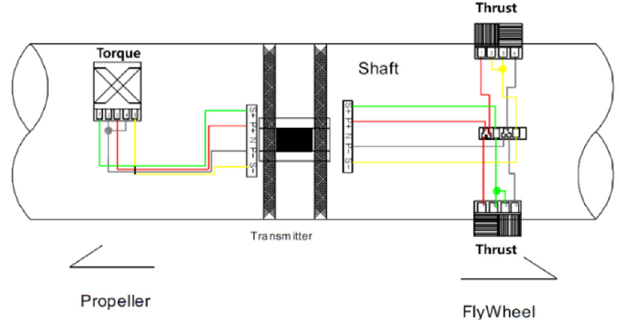
Figure 3. Schematic representation of strain gauges.